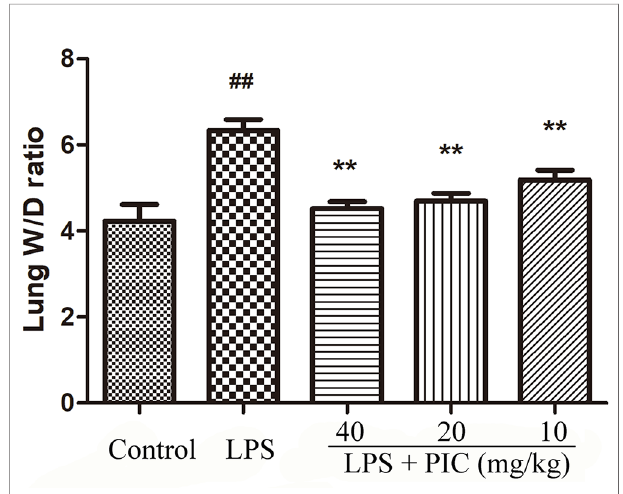
FIGURE 1 | Lung wet to dry (W/D) ratio. The lung wet weight was divided by its dry weight to calculate the lung W/D ratio to evaluate the severity of pulmonary edema. ## p < 0.01 is signi fi cantly different from the control group; ** p < 0.01 are signi fi cantly different from the lipopolysaccharide (LPS)